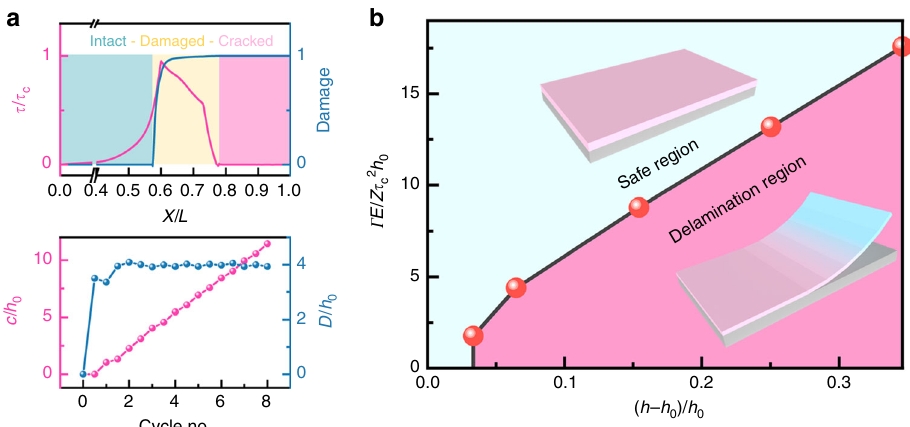
Fig. 5 Damage analysis of PProDOT thin fi lm upon redox reactions. a Upper panel: Sketch of the shear stress pro fi le (left y axis) and the interfacial damage function (right y axis) along the interface after the 4 th oxidation reaction. Lower Panel: The evolution of the crack length (magenta dots), c/h 0 , and the size of the damaged zone (blue dots), D/h 0 , as a function of the cyclic number of the redox reaction. b A phase diagram of interfacial delamination in electrochromic thin fi lm in the space of the dimensionless breathing strain and interfacial toughness. The solid spheres represent the numerical results, while the line is drawn to delineate the boundary between the intact and delaminated